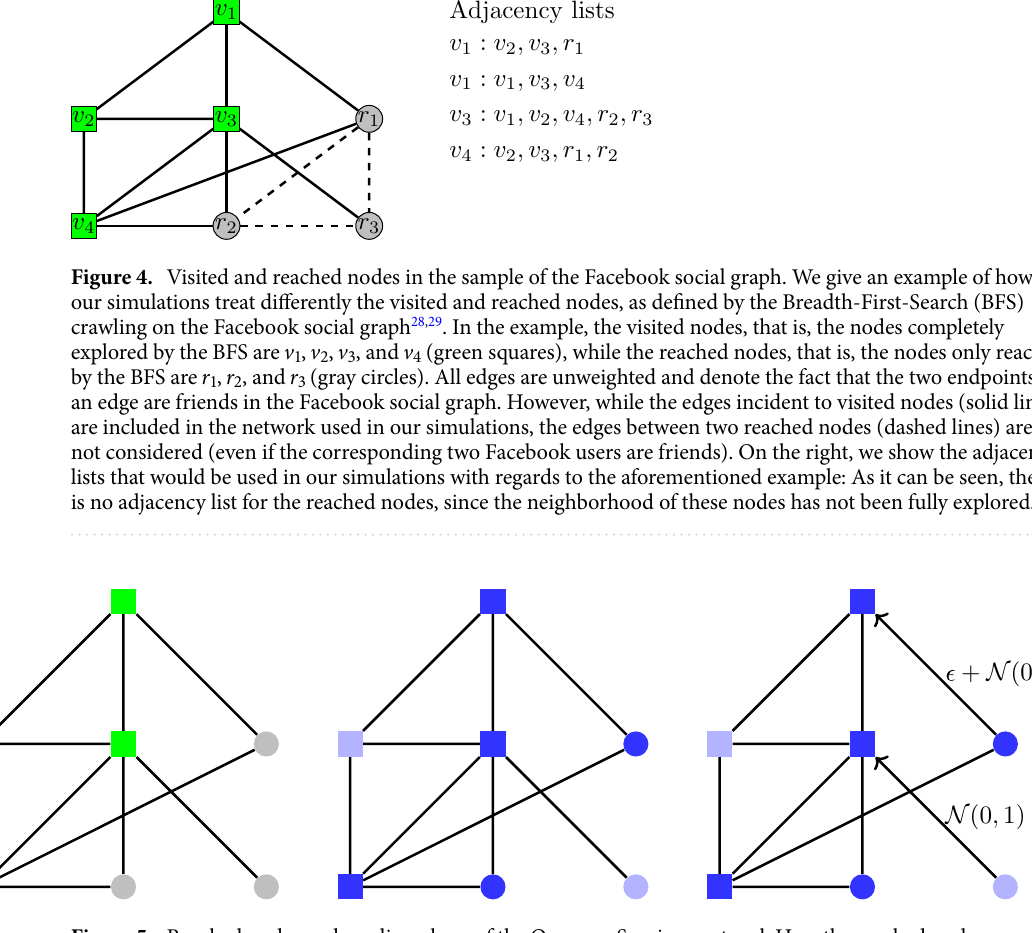
Figure 5. Reached nodes and sending phase of the Quorum-Sensing protocol. How the reached nodes participate to the sending phase of the Quorum-Sensing protocol (reached nodes are the gray circles on the left). Similarly to visited nodes (green squares), reached nodes can be either obedient citizens or rebels: for example, on the center, we have two reached nodes which are rebels (dark blue circles) and one which is an obedient citizen (light blue circle). As any other node of the network, a rebel reached node plays the sending phase of the Quorum-Sensing protocol and sends to each of its neighbors (which is a visited node) a value distributed by ε + N ( 0, 1 ) , while an obedient citizen reached node sends to each of its neighbors (which is a visited node) a value distributed by N ( 0, 1 ) (see on the right). Only the rebel visited node will execute the detecting phase of the protocol in order to decide whether to output “many”. Hence, the success probability has to refer to fraction of rebel visited nodes that output “many”, among total rebel visited